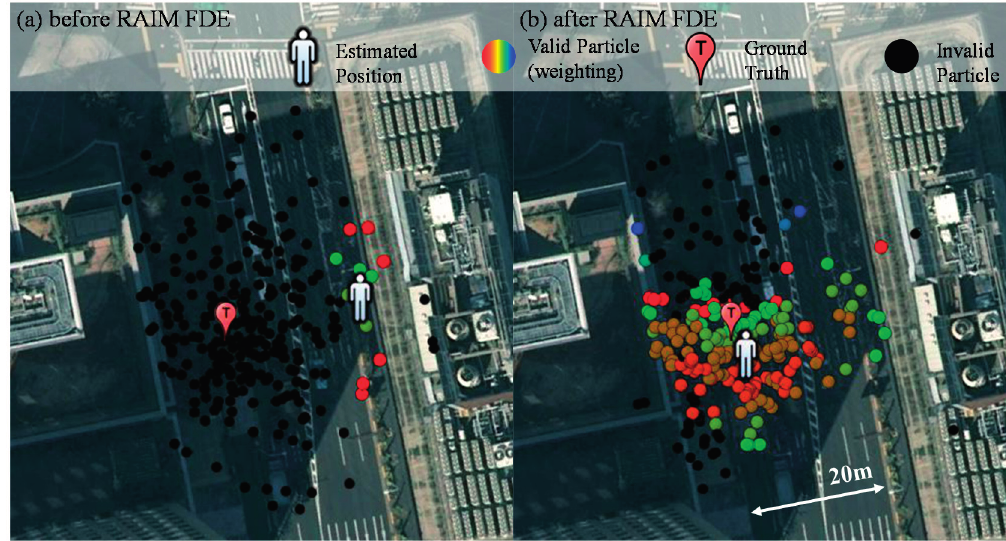
Figure 8. Weighting of all the particles of the point 264,239 before ( a ) and after RAIM ( b ). The color of the particle indicates the weighting of each particle. Red and blue indicates the highest and lowest weighting, respectively.